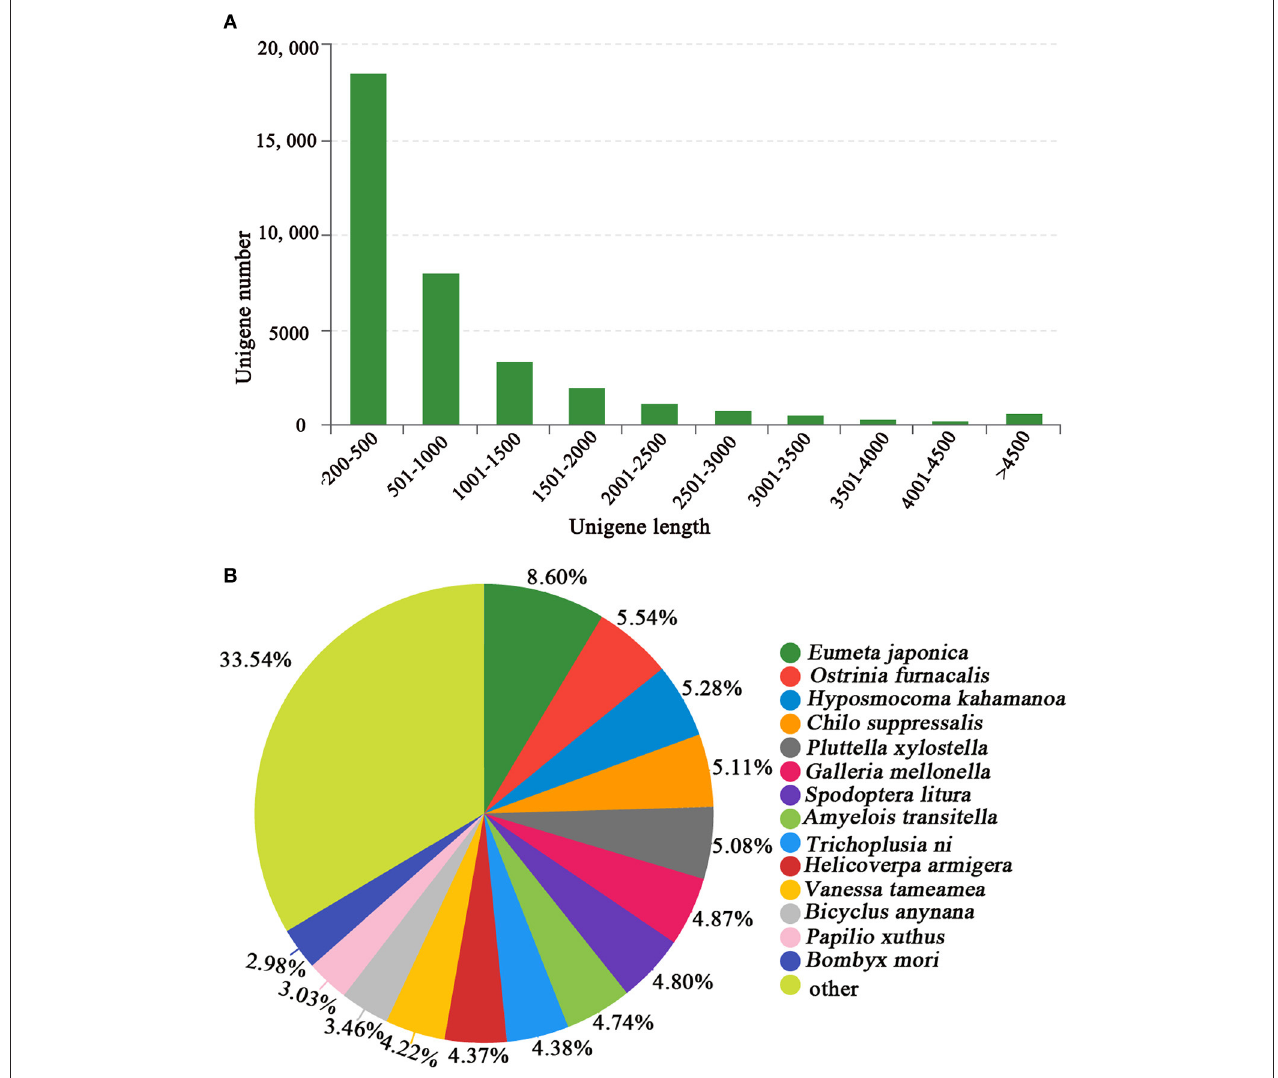
FIGURE 2 | (A) Length distribution of E. signifer unigenes and (B) BLASTx comparison of unigenes in the E. signifer transcriptome with those of other